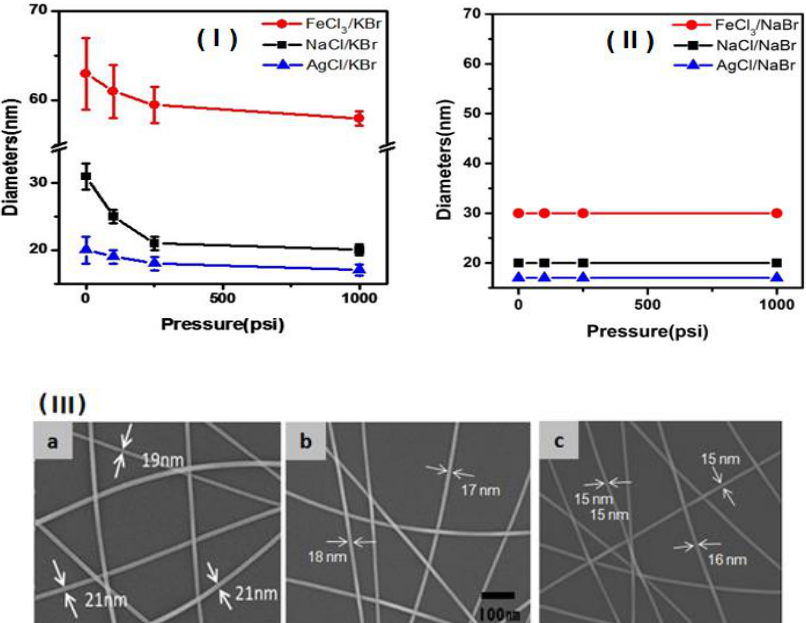
Figure 2. Ag NW diameter vs. pressure in the presence of various salts: [ I ] AgCl – KBr, NaCl – KBr, and FeCl 3 – KBr and [ II ] AgCl – NaBr, NaCl – NaBr, and FeCl 3 – NaBr (the error range is observed within the range of 2~3 nm, respectively). [ III ] SEM images of the Ag NWs synthesized in the presence of AgCl – KBr salts; ( a ) 19 – 25, ( b ) 17 – 18, and ( c ) 15 – 16 nm, respectively. These NWs correspond with 0, 250, and 1000 psi (69 bar), respectively.